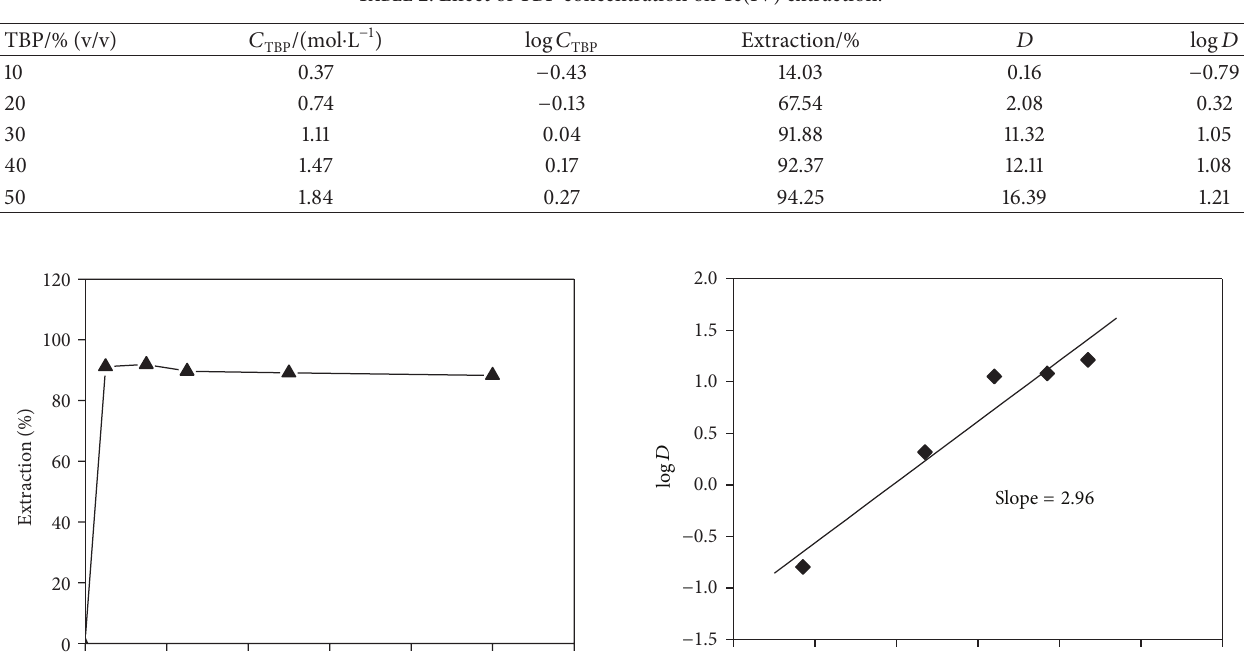
Table 2: Effect of TBP concentration on Te(IV) extraction.